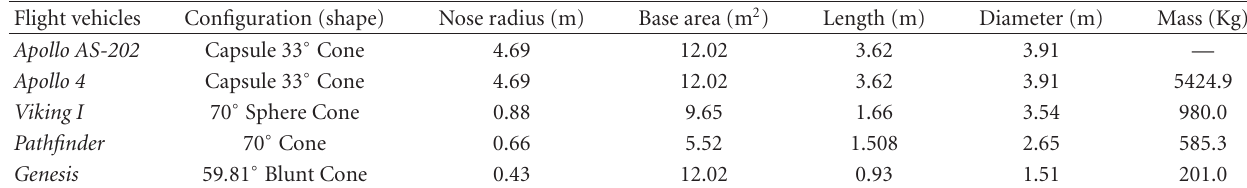
Figure 20: Galileo probe heat shield ablation: NASA picture. Table 8: Database of entry vehicles and flight vehicle geometric